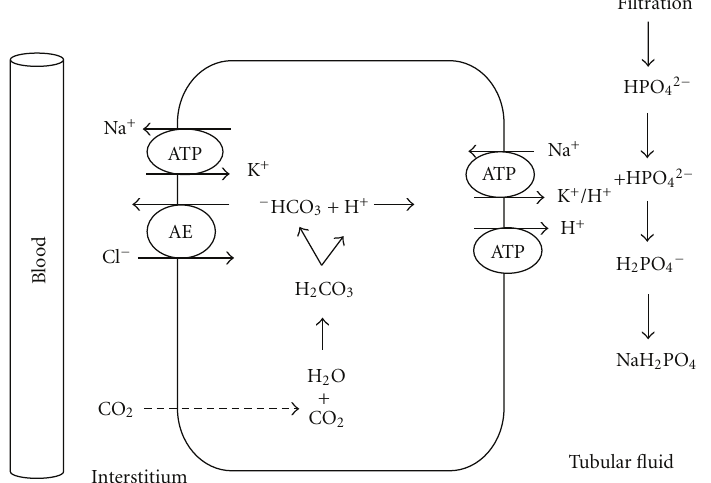
Figure 3: Titration of nonvolatile acids. H + secreted into the tubular fluid combines with phosphate (urinary bu ff er), and a new − HCO 3 is generated within the